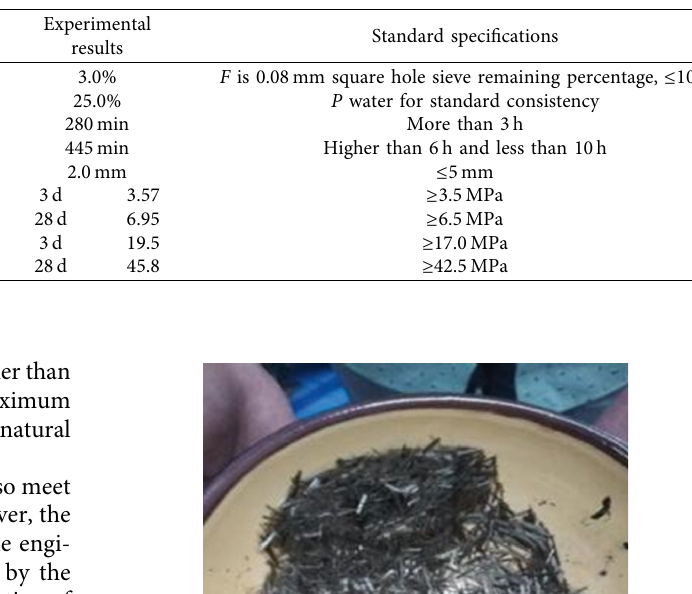
Table 2: The results of cement test performance.